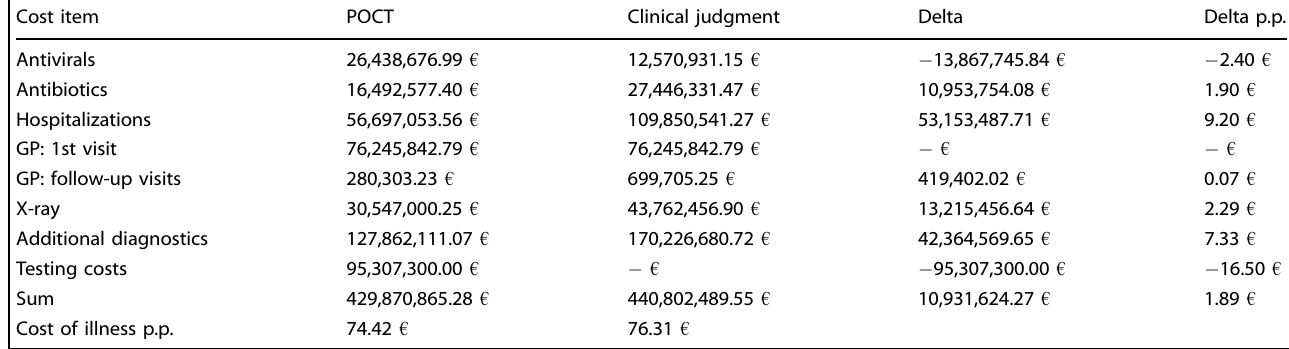
Table 6. Calculation (age-group speci fi c) adults.